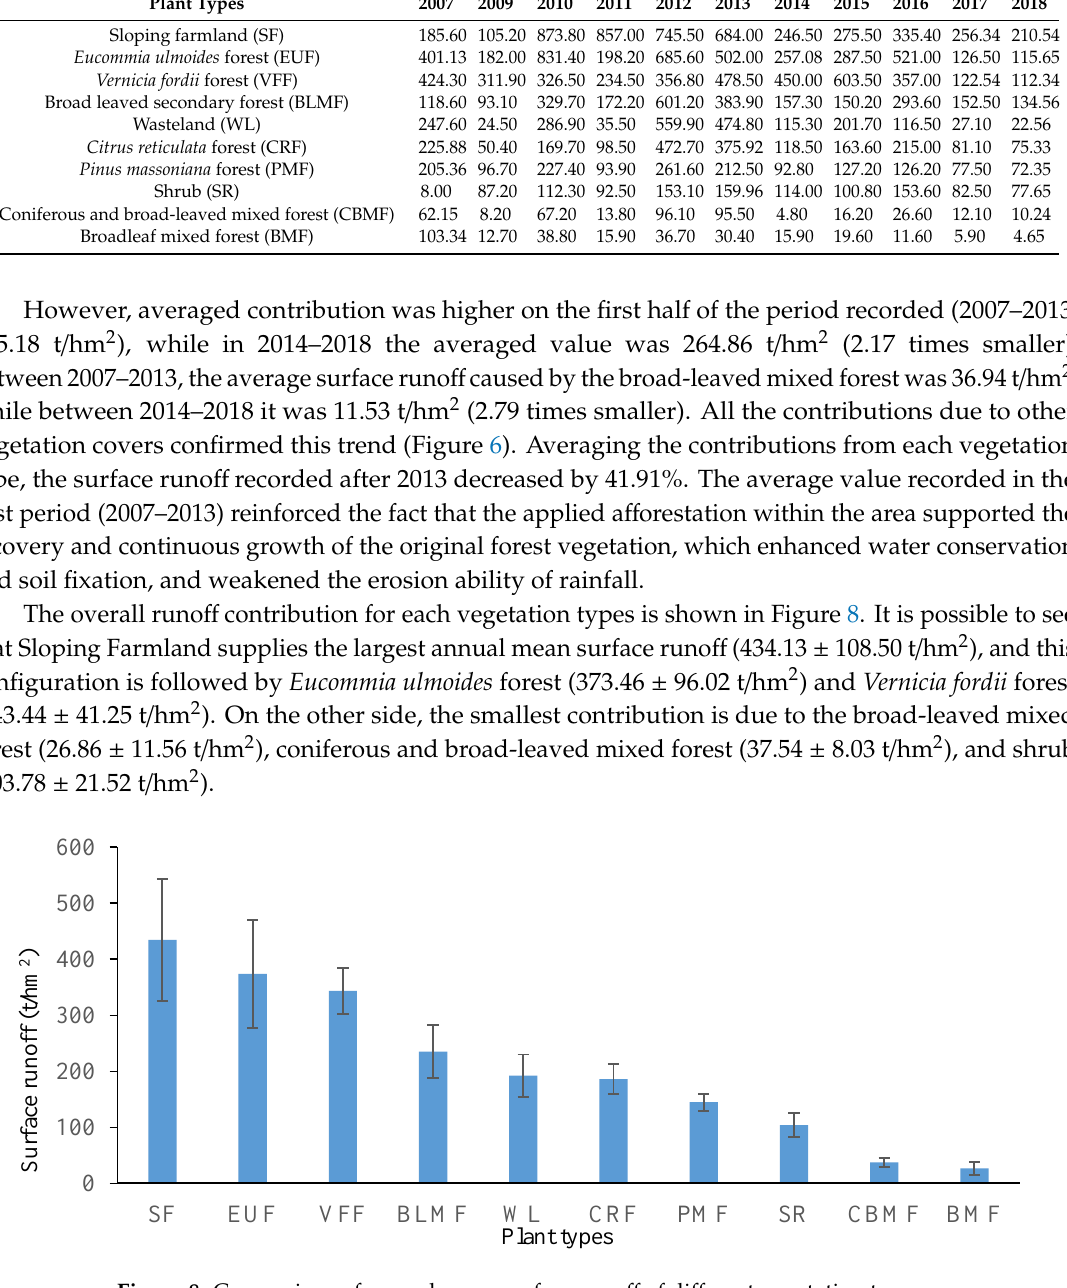
Figure 8. Comparison of annual mean surface runoff of different vegetation types.